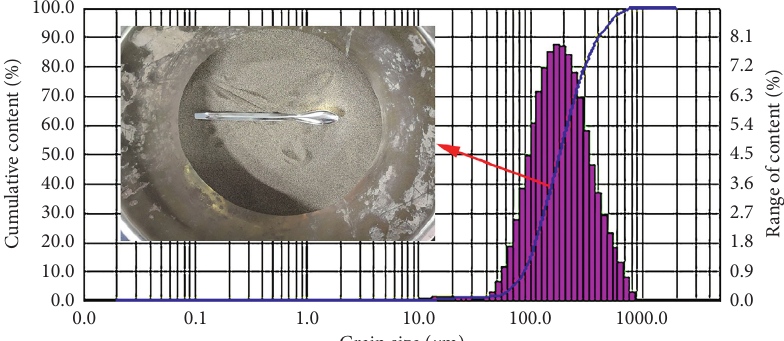
Figure 3: Grading curve and sand sample.